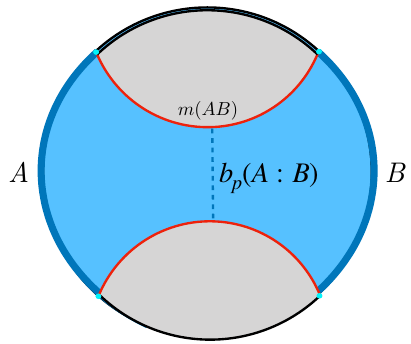
Figure 1 . Illustration of the homology-region cross section E w ( A : B ), conjectured to be dual to the entanglement of puri(cid:12)cation (1.1). The AB homology region r ( AB ) is shown in blue. E w ( A : B ) is de(cid:12)ned as the area of the minimal surface b p ( A : B ) in r ( AB ) homologous to A relative to m ( AB